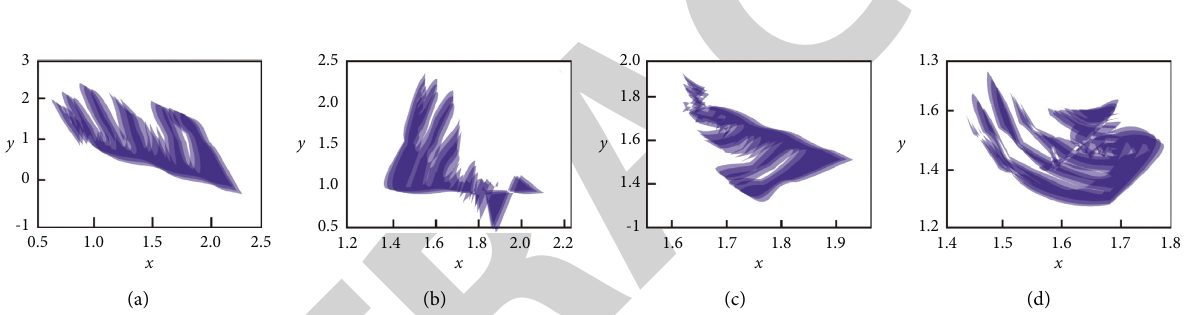
Figure 7: The phase diagram of the system changing with the parameter q : (a) q � –1.25; (b) q � –0.74; (c) q � –0.35; (d) q � –0.24.